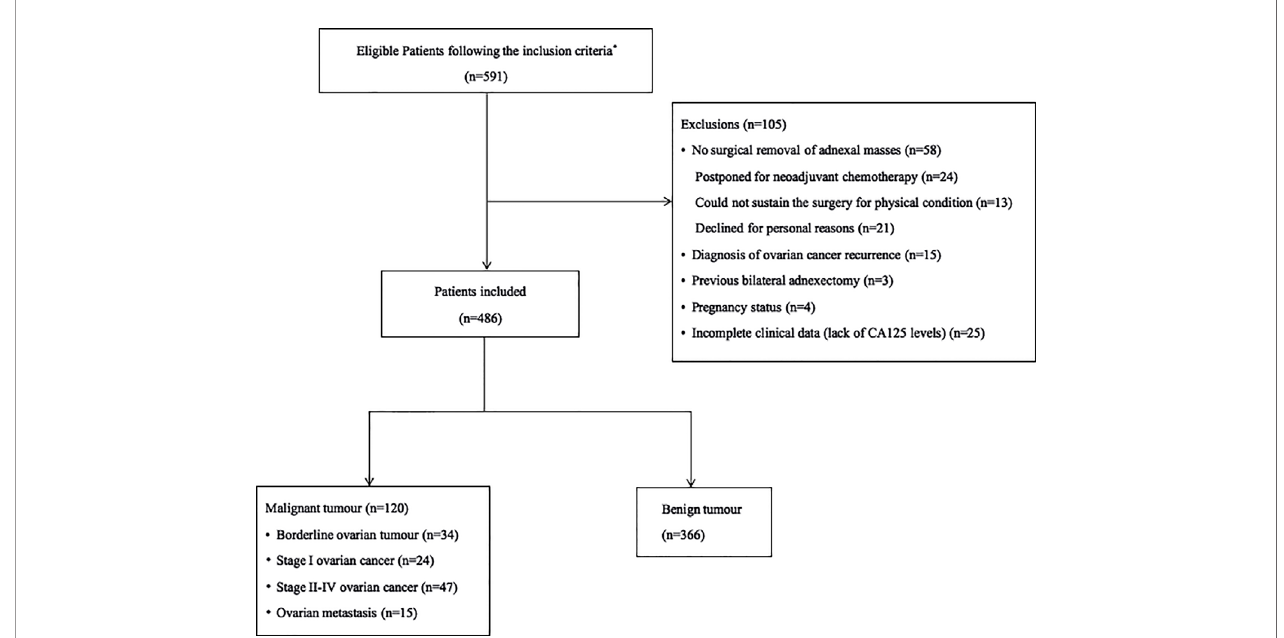
FIGURE 1 | Flow diagram summarizing the inclusion of patients with adnexal masses in the study. *The inclusion criteria were as follows: (1) patients with at least one adnexal mass detected by transvaginal or transrectal ultrasonography, (2) patients who were prepared to undergo surgery, (3) patients with a time interval between ultrasound and surgery within 30 days, and (4) patients without a previous history of ovarian cancer.